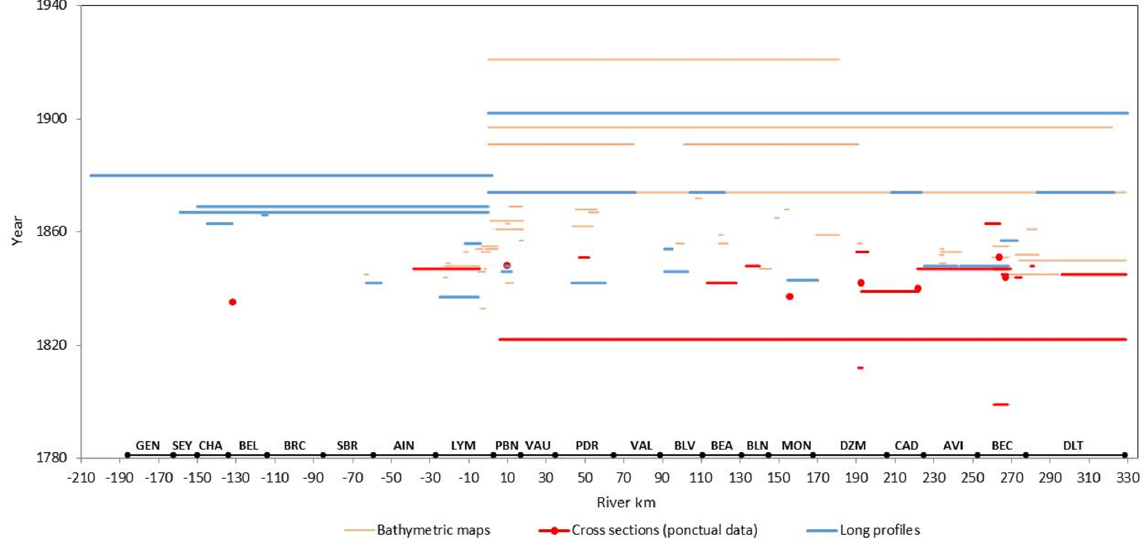
Figure 8. Longitudinal coverage of the topo-bathymetric dataset. The spatial extent of present river reaches is superimposed on the x axis (see Fig. 1 for